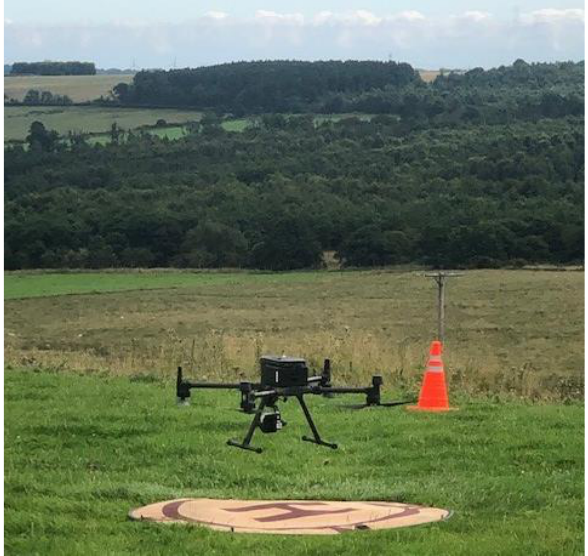
Figure 4. DJI Zenmuse P1 M300 RPAS data acquisition.